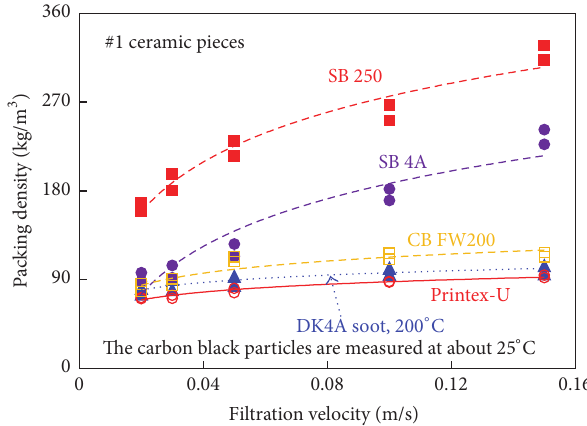
Figure 14: The packing density of the different particles.